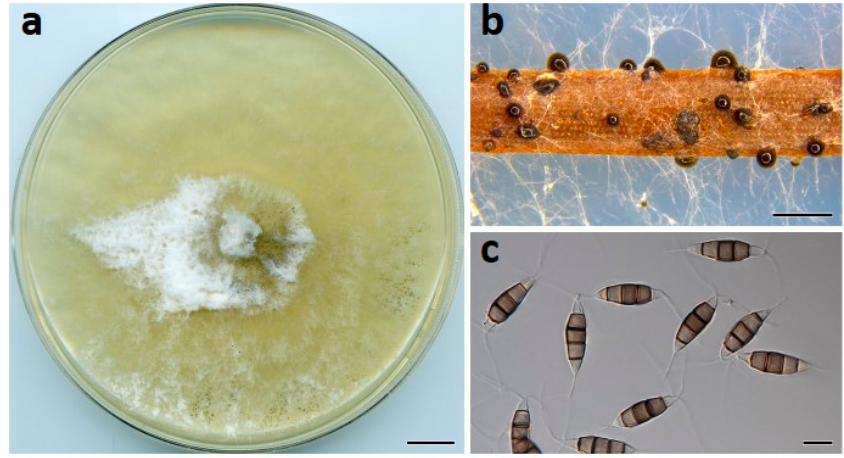
Figure 3. Neopestalotiopsis drenthii (BRIP 72264a). ( a ) Two-week-old colony on PDA, ( b ) conidiomata on pine needle agar, and ( c ) conidia. Scale bars: a = 1 cm; b = 1 mm; c = 10 µm. MycoBank: MB840916.